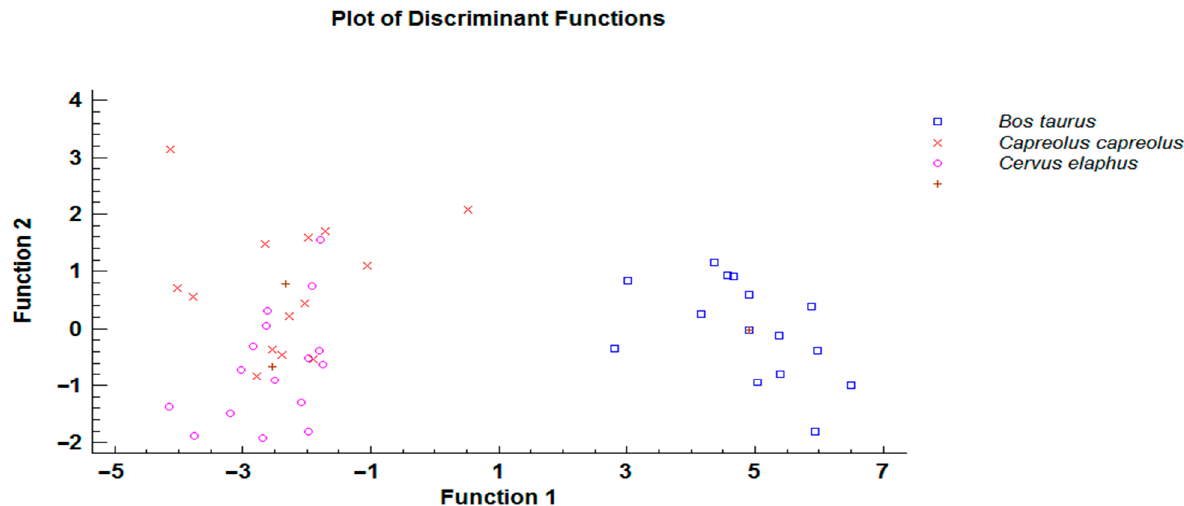
Figure 5. Scatter plot of discriminant function analysis comparing selected morphological characteristics of Ostertagia leptospicularis females derived from different host species (brown crosses indicates particular